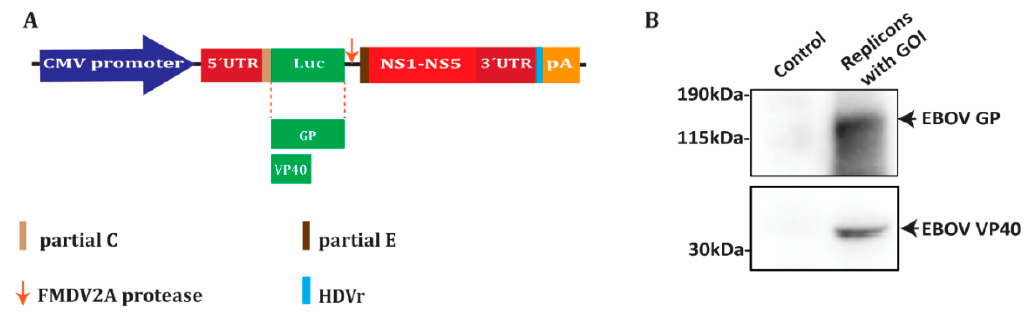
Figure 5. Expression of EBOV vaccine candidates using the KUNV replicon. ( A ) The luciferase reporter gene (Luc) was substituted with genes coding EBOV GP or VP40 in the DNA replicon. ( B ) Immunoblotting of cell lysates 2 days after transfection with EBOV GP or EBOV VP40 replicons versus the untransfected cell control.